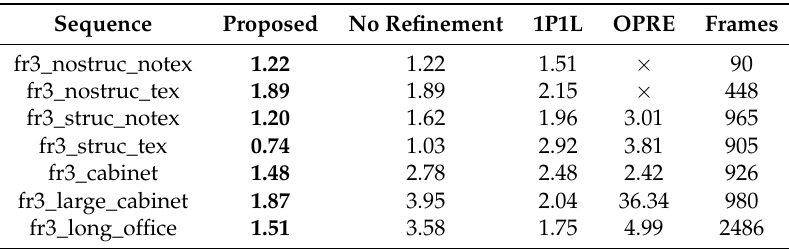
Table 2. Comparison of average ARE (degrees) on TUM RGBD Dataset. Sequence